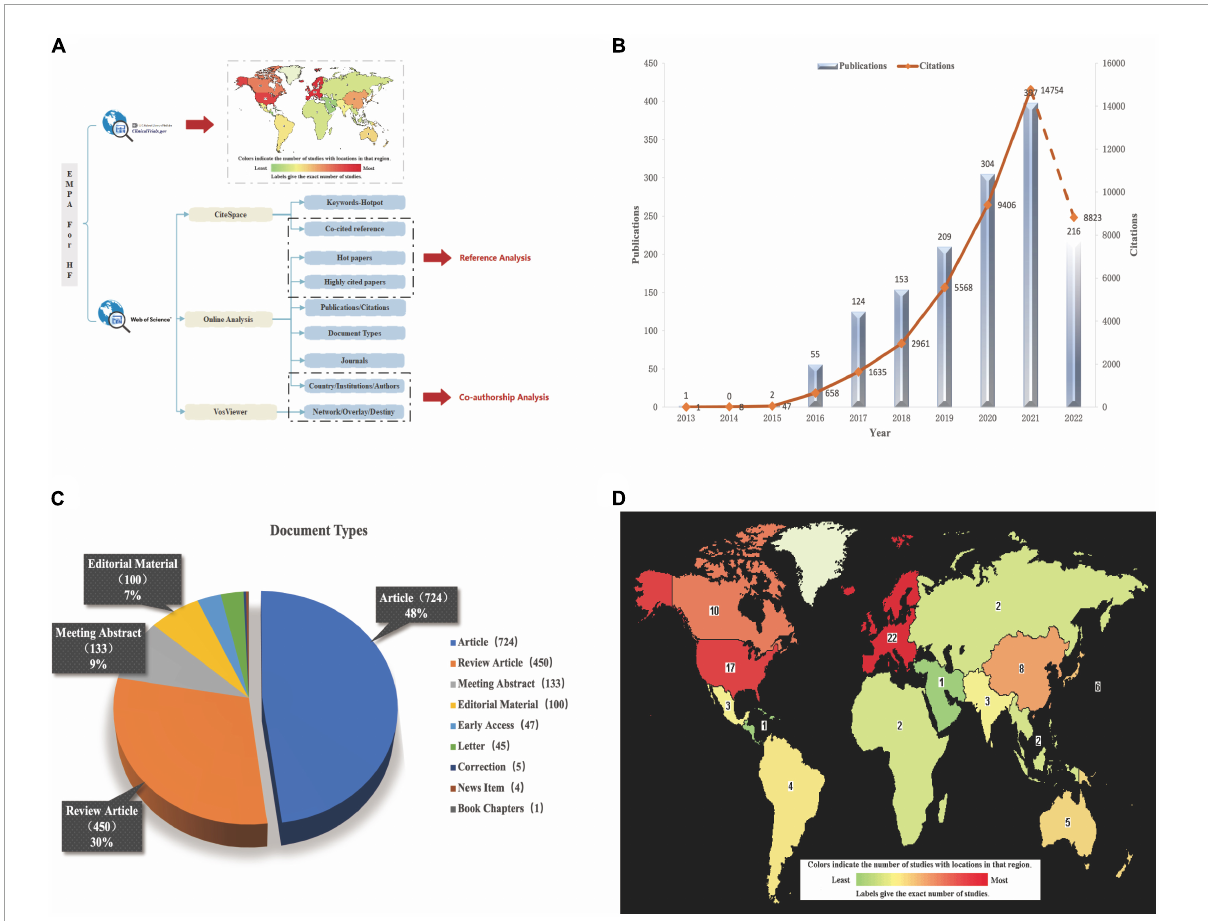
FIGURE1 (A) The flow diagram of scientometric analysis. (B) The trend of Publications and Citations. (C) The document types of all literatures. (D) Global distribution of clinical trials about EMPA for HF